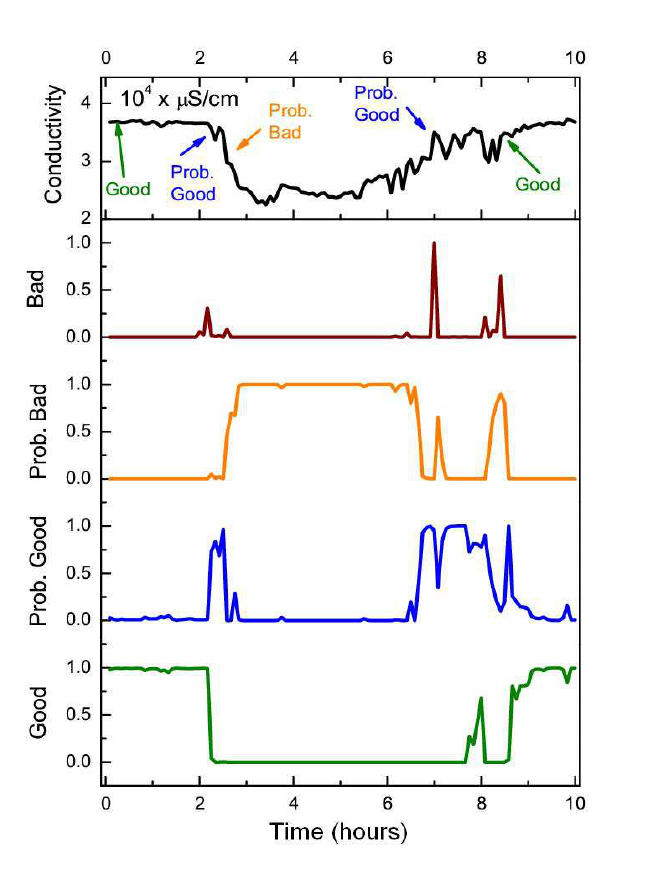
Figure 7. The top time-series of each figure corresponds to a section of sensor readings from the conductivity sensor at 1 m that have been assessed by a human expert and automatically flagged by the DBN. The four bottom series correspond to the posterior probabilities of the (between 0–1) quality states of each sensor sample in the network. The arrows upon the top time-series correspond to the points at which the expert’s assessment has changed to the quality state